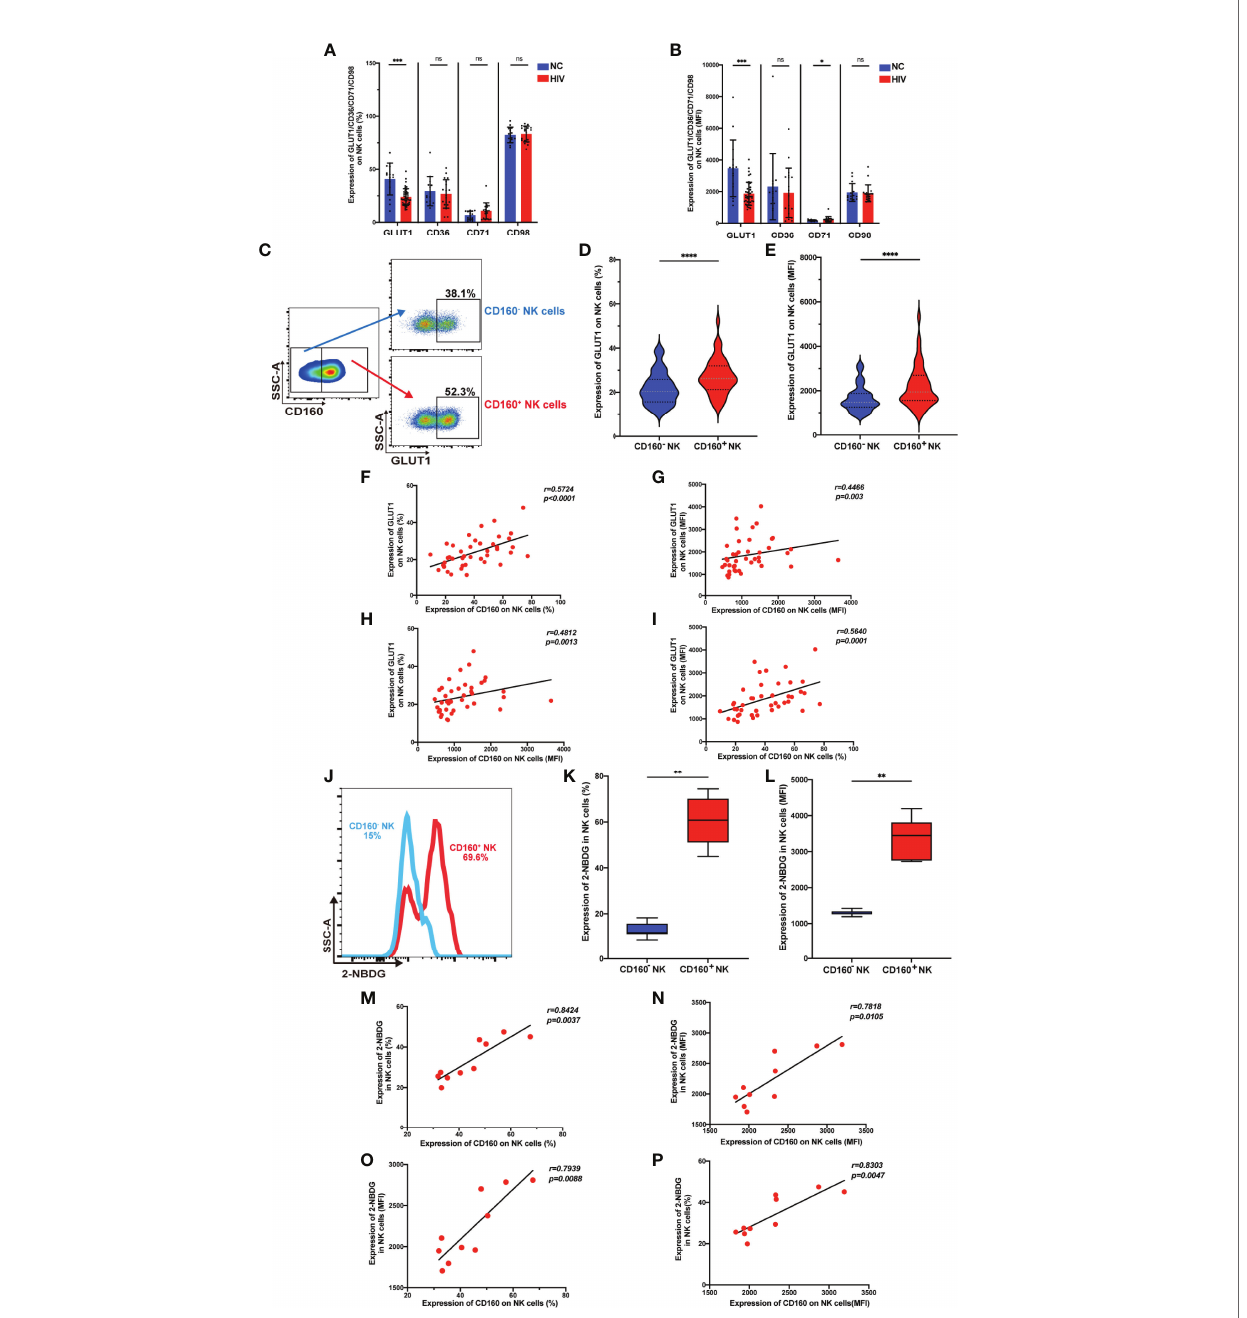
FIGURE 3 | CD160 expression is associated with enhanced glucose transport and uptake capacity of NK cells. (A, B) Percentages (A) and MFI (B) of GLUT1 (GLUT1: NC, n = 15; HIV, n = 43), CD36, CD71, CD98 (CD36, CD71, CD98: NC, n = 14; HIV, n = 19) on total NK cells from HIV-infected individuals were determined by fl ow cytometric analysis. (C) Representative cytometry dot plots for GLUT1 expression on CD160 - and CD160 + NK cells in HIV-infected individuals. (D, E) Comparison of percentages (D) and MFI (E) of GLUT1 expression between CD160 – and CD160 + NK cells in HIV-infected individuals (n = 42). (F – I) Correlation between CD160 and GLUT1 expression on total NK cells (n = 42). (J) Representative histograms showing 2-NBDG uptake by CD160 - and CD160 + NK cells in HIV- infected individuals. (K, L) Paired comparison of the percentages (K) and MFI (L) showing 2-NBDG uptake between CD160 – and CD160 + NK cells in HIV-infected individuals (n = 10). (M – P) Correlation between CD160 expression and 2-NBDG uptake in total NK cells from HIV-infected individuals (n = 10). The mean fl uorescence intensity of GLUT1, CD36, CD71, CD98, and CD160 in (B, G, H, I, N, O, P) was from total NK cells. And the mean fl uorescence intensity of GLUT1 and 2-NBDG in (E, L) was from CD160 - and CD160 + NK cells, respectively. A non-parametric Mann-Whitney U test was used for comparisons between two groups. A Wilcoxon matched-pairs signed-rank test was applied for paired-group comparisons. A Spearman ’ s rank test was used for analysis of correlation; * P < 0.05; ** P < 0.01; *** P < 0.001; **** P < 0.0001; ns, no signi fi cance. Data are represented as means ±